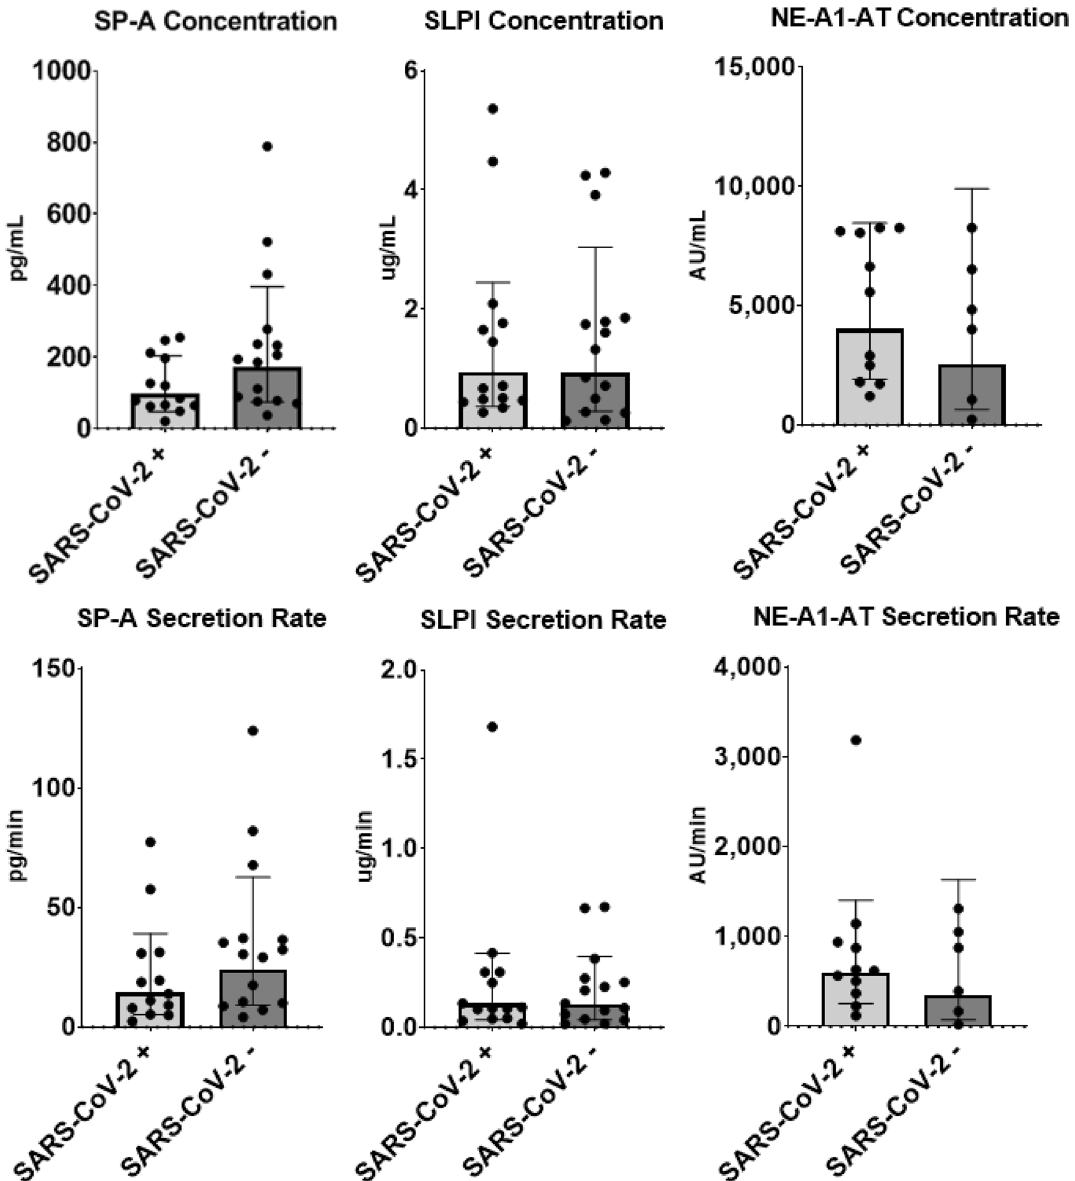
Figure 3. Concentrations and secretion rates of biomarkers of lung inflammation in athletes who had been infected with SARS-CoV-2 and those who had remained infection-free. No significant differences were found in secretory leucocyte protease inhibitor (SLPI), salivary surfactant protein A (SP-A), salivary neutrophil Elastase- alpha-1-antitrypsin complex (NE-A1-AT). Concentrations and secretion rates for SP-A (n SARS-CoV-2 + = 13; n SARS-CoV-2- = 15), SLPI (n SARS-CoV-2 + = 14; n SARS-CoV-2- = 15) and NE-A1-At (n SARS-CoV-2 + = 11; n SARS-CoV-2- = 6) are presented as geometric means ±